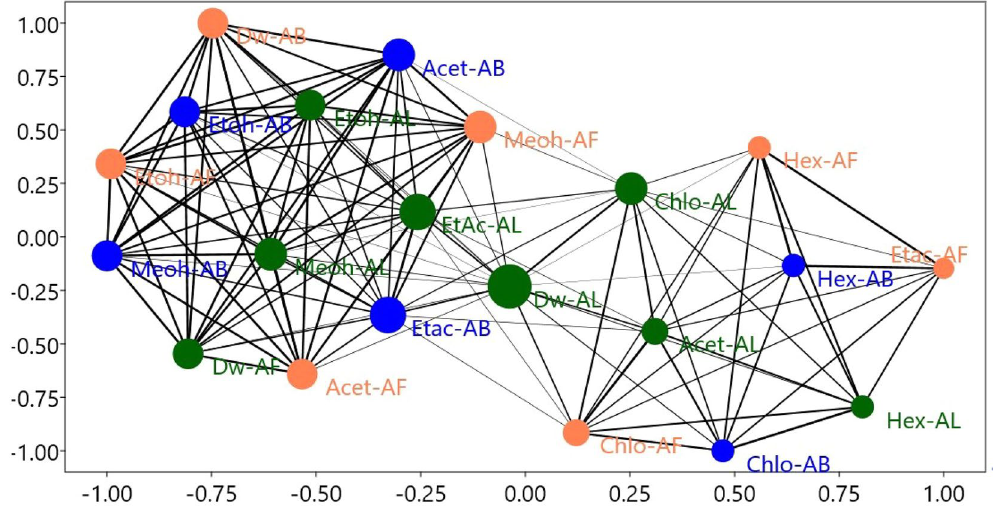
Figure 3. Showing interaction networking of solvent extract of T.